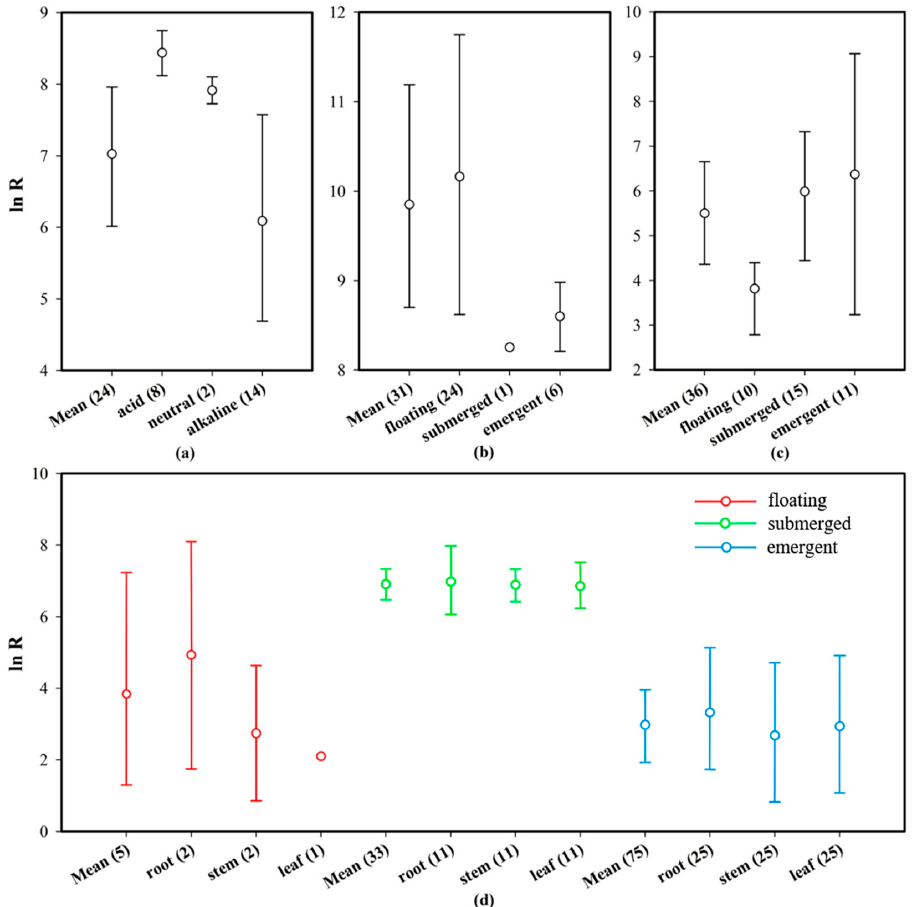
Figure 7. Mean effect sizes (ln R) of Hg concentrations in different life habit plants, and plant organs in terms of pH, and life habits. The error bars represent 95% bootstrapped CIs, and the numerals below the x-axis represent the number of observations in each category. “Mean” indicates the overall effect considering all observed objects in the same category. ( a ) Effect size of pH on Hg absorption by plant roots; ( b ) effect size of life habit on Hg absorption by plants in neutral and acidic water (pH < 7.5); ( c ) effect size of life habit on Hg absorption by plants in alkaline water (pH > 7.5); and ( d ) effect size of plant organs on Hg absorption by different life habit plants.